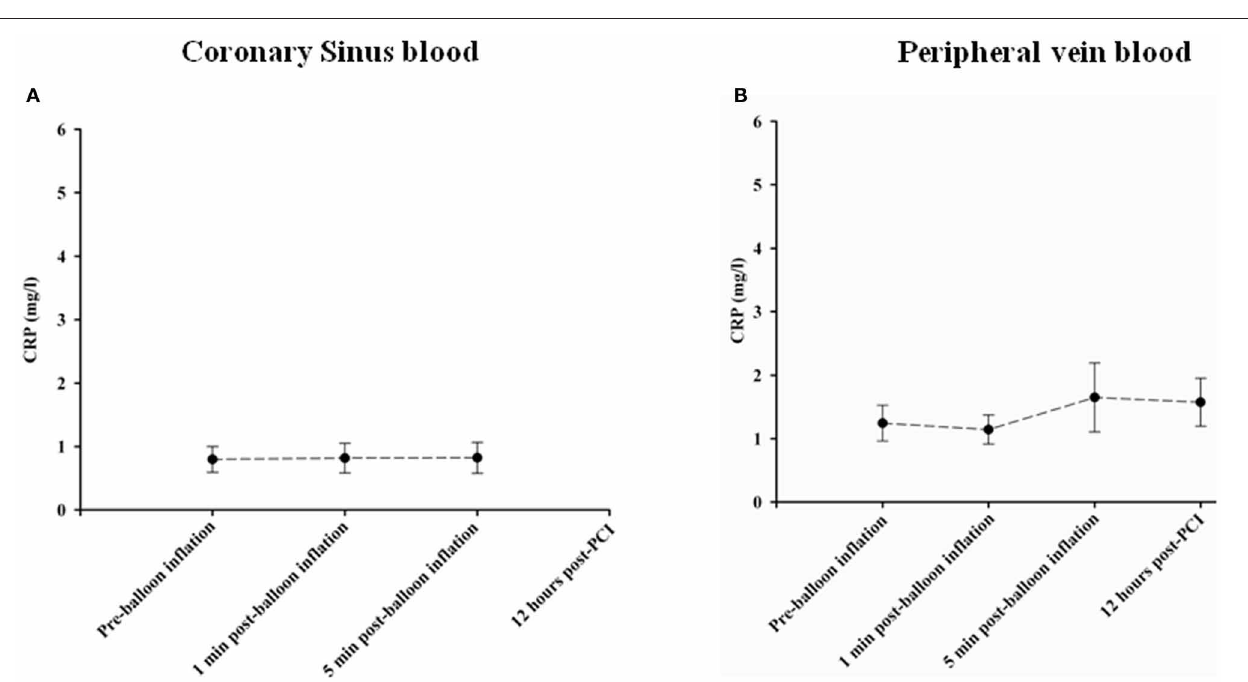
FIGURE 5 | Changes in CPR concentrations in Coronary sinus (A) and peripheral (B) blood at different time course points following balloon inflation.